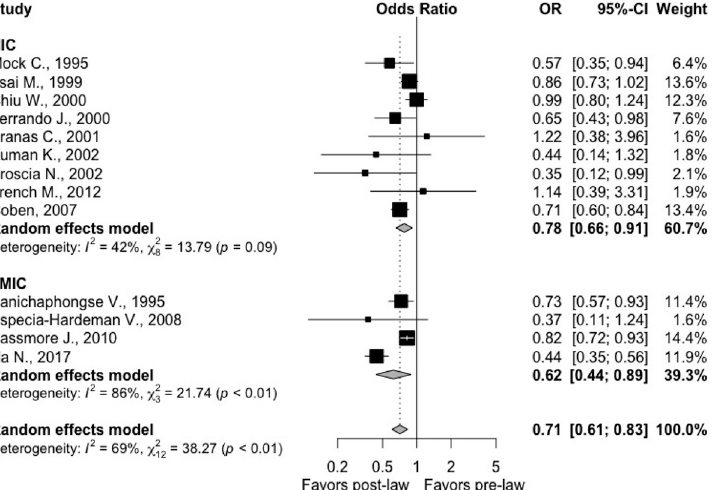
Fig 3. Forest plots demonstrating the OR of motorcycle fatality following implementation of helmet legislation (95% CI) in HICs from 8 studies and in LMICs from 4 studies. Solid squares represent the point estimate of each study, and the centers of the clear diamonds represent the estimate of the intervention effect for HIC vs. LMIC, while the center for the black diamond represents the overall OR for all studies. Horizontal lines represent 95% CIs for the original studies, and the width of the diamonds represents the 95% CI of the pooled ORs. Prediction interval for the OR of helmet usage comparing post- to pre-law enactment in HIC: (0.53; 1.14). In 95% of all meta-analyses, the range of the prediction interval will capture the true effect size of 95% of all new studies in HIC. Prediction interval for the OR of helmet usage comparing post- to pre-law enactment in LMIC: (0.13; 2.90). In 95% of all meta-analyses, the range of the prediction interval will capture the true effect size of 95% of all new studies in LMIC. CI, confidence interval; HIC, high-income country; LMIC, low- and middle-income country; OR, odds